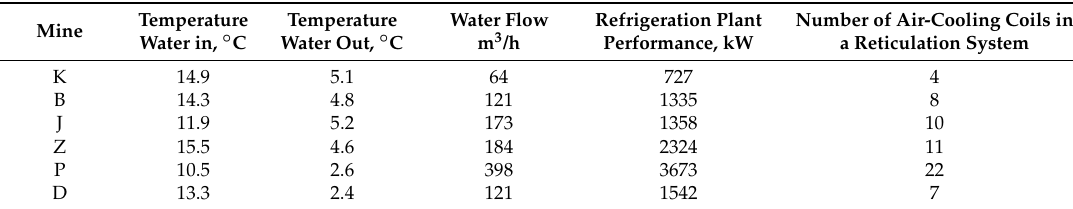
Table 2. Results of the performance of the tested refrigeration plants-evaporator